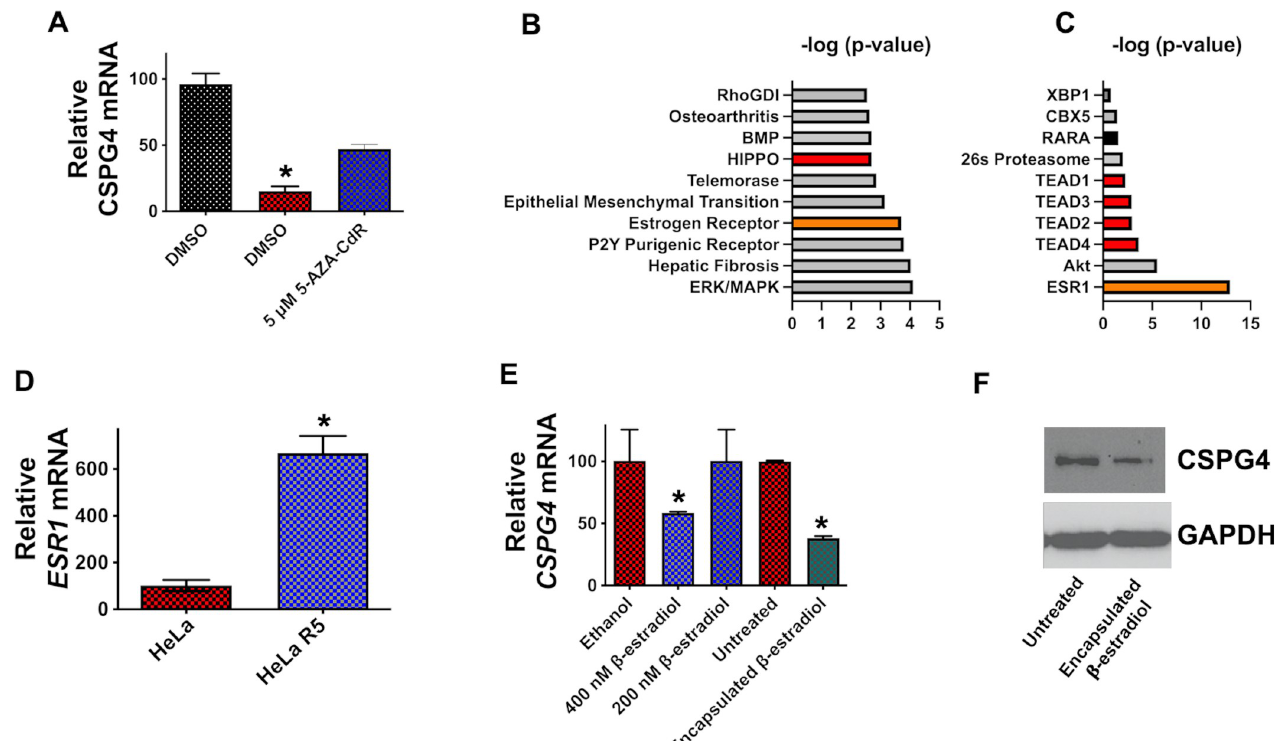
Fig 3. Regulation of CSPG4 expression. ( A ) HeLa R5 cells were exposed to 5-AZA-CdR for 48 h and then RT-qPCR was used to quantify CSPG4 transcripts. RT-qPCR data are presented as mean (n = 3) ± S.D. ( B ) The top statistically significant canonical pathways correlating (positive z score) with HeLa R5 cells. ( C ) Upstream regulators predicted to be activated in HeLa R5 cells based on integrated pathway analysis. ( D ) Comparison of ESR1 transcripts between HeLa and HeLa R5 cells presented as the mean (n = 3) ± S.D. ( E ) HeLa cells were cultured in 0.5% charcoal stripped FBS and phenol red free media for 2 h prior to a 24 h exposure to non-encapsulated ß-estradiol or encapsulated ß-estradiol. RT-qPCR was then utilized to quantify CSPG4 transcripts exhibited as mean (n = 3) ± S.D. ( F ) HeLa cells were exposed to encapsulated ß-estradiol for 24 h and then an immunoblot was performed on the resulting protein extracts. * p < 0.05 determined by Student’s